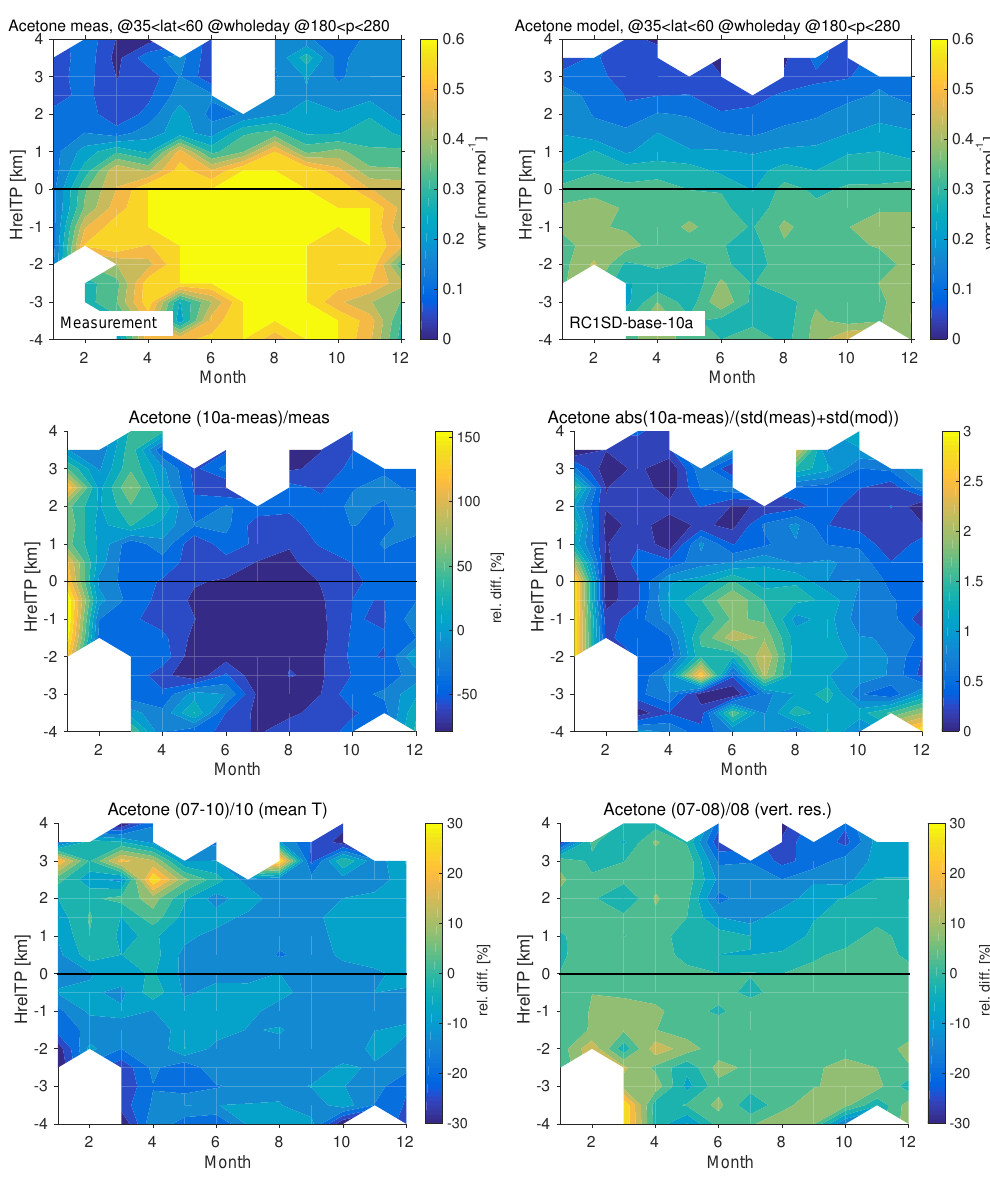
Figure 22. As Fig. 19, but for acetone. The maximum of measured acetone values in summer is 1.5nmolmol − 1